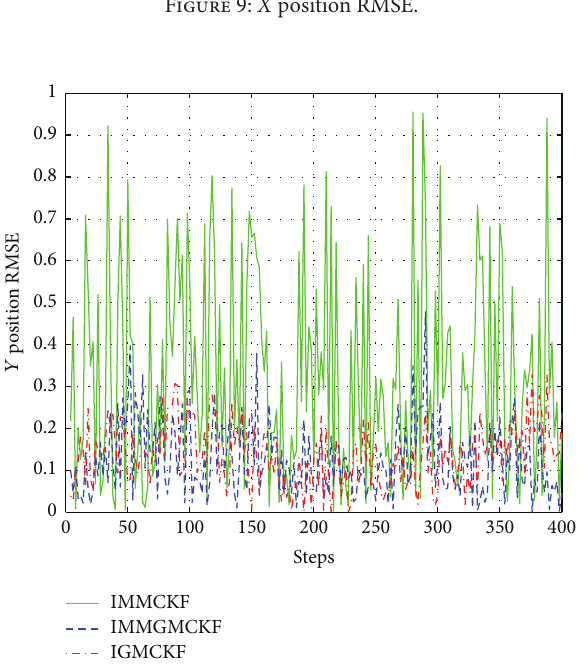
Figure 10: Y position RMSE.